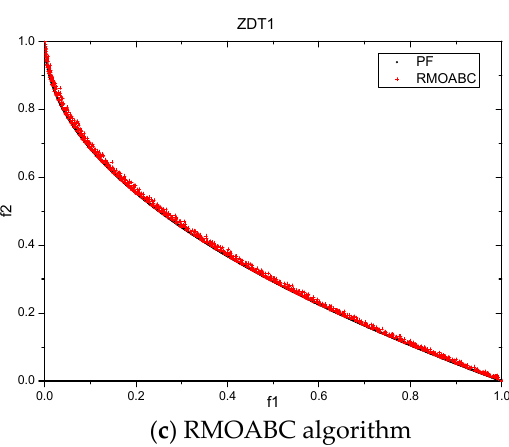
Figure 2. Plots of the non-dominated front found by the three algorithms for 2-objective ZDT1 test instance. ( a ) NSGA-II algorithm; ( b ) MOEA/D algorithm; ( c ) RMOABC algorithm. .0/).